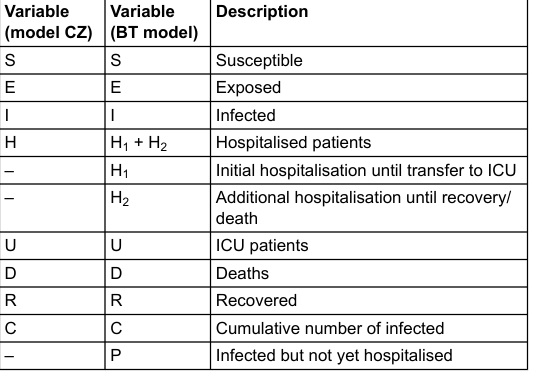
Uncertainty and forecasting